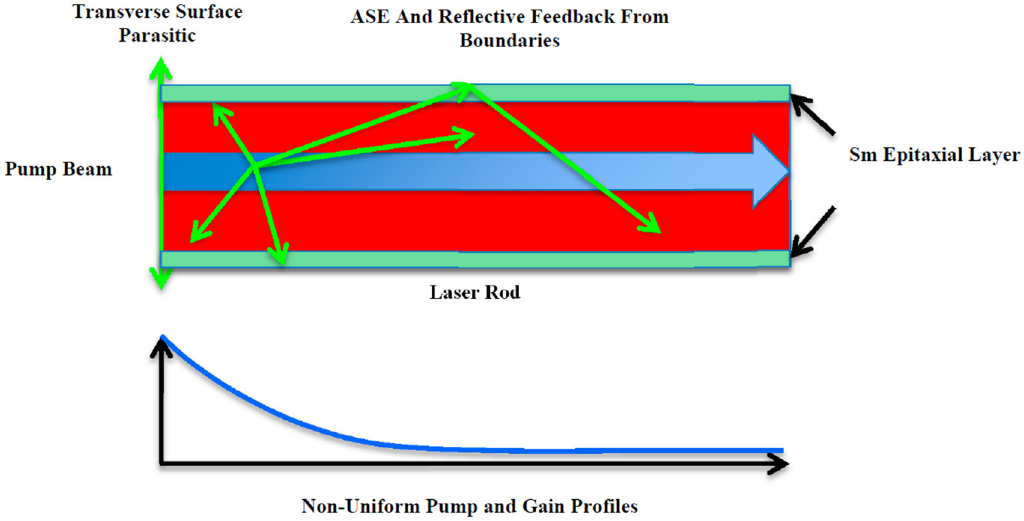
Figure 36. Side view of an end-pumped laser rod or slab, showing the emitted fluorescence and absorption in Sm:YAG cladding layer. The non-uniform absorption gives rise to a possible surface parasitic at the pump beam entrance face where the transverse gain is largest.